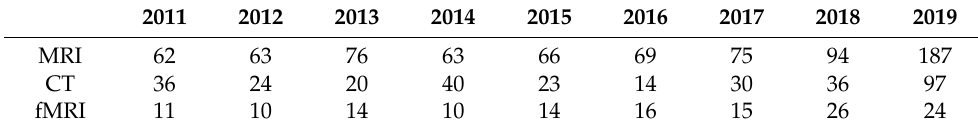
Table 2. Number of articles included in the analysis, per year and imaging